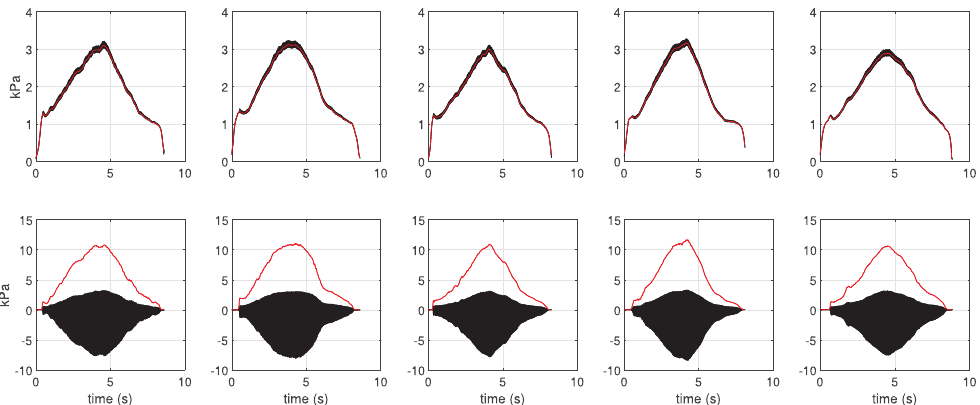
Figure 6. Five crescendo-decrescendo maneuvers performed by the trumpet player. Top: mouth pressured measured (black) and low-pass fi ltered (red). Bottom: mouthpiece pressure (black) and peak-to-peak envelope (red).